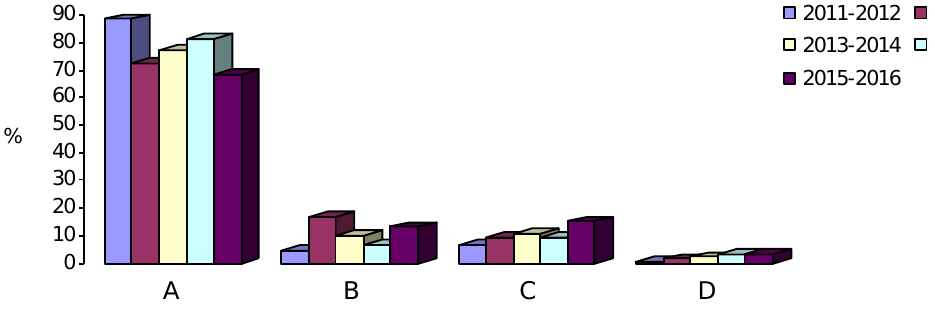
Fig.1. Students’ distribution into health groups for recent five academic years 2011-2016 A – main group; B – preparatory group; C – special group; D – group of therapeutic physical culture (TPC); HG – health